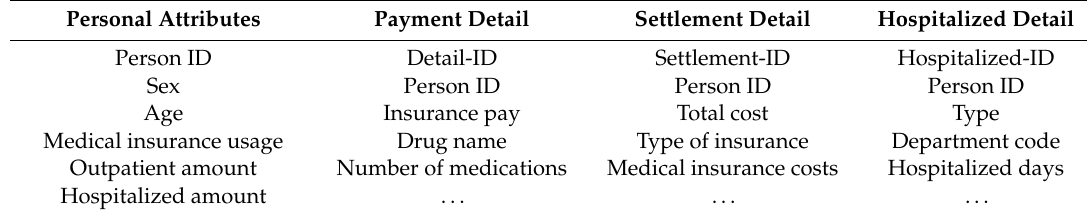
Table 1. Main data structure in the digital healthcare